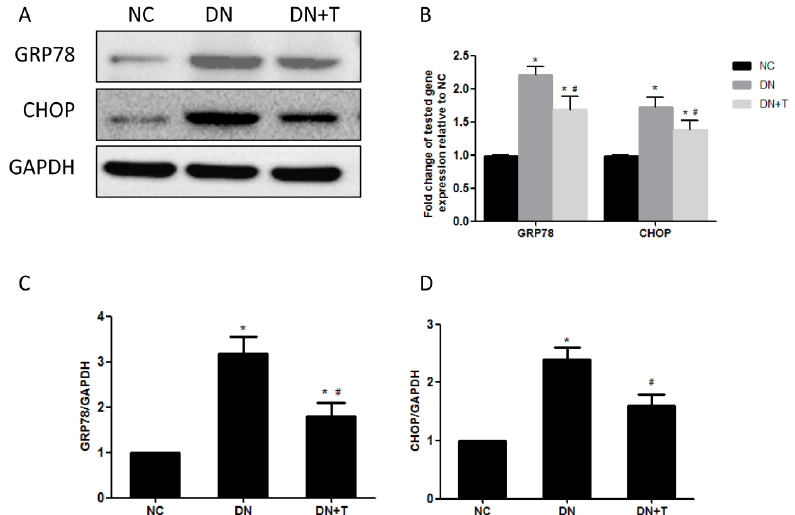
Figure 4. Effect of TUDCA on diabetes ‐ induced ER stress in the renal cortex of db/db mice. TUDCA administration for eight weeks could decrease diabetes ‐ induced ER stress markers. ( A ) The kidney tissue lysates were subjected to Western blot analysis with specific antibodies against ER stress markers (GRP78 and CHOP). Each sample was normalized to GAPDH expression; ( B ) Relative transcript levels of GRP78 and CHOP were detected by real ‐ time PCR and normalized to expression of GAPDH. Densitometric analysis of Western blots for GRP78; ( C ) and CHOP; ( D ) protein in extracts from renal cortex. Values are presented as means ± SEM ( n = 10). * p < 0.05 versus NC group. # p < 0.05 versus DN group.